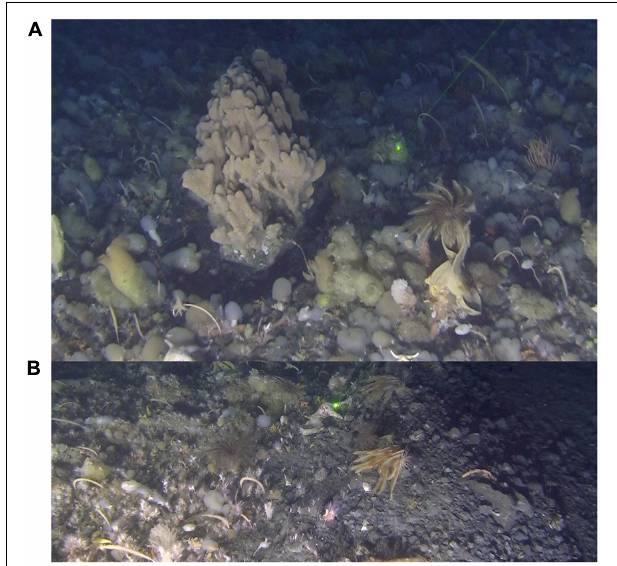
FIGURE 5 | VME at Hope Bay, Antarctic Sound, ∼ 100 m (Dive 1). (A) Dense assemblage of VME indicator taxa. (B) The transect at Hope Bay (Dive 1) crossed into a very distinct ice-scour zone.